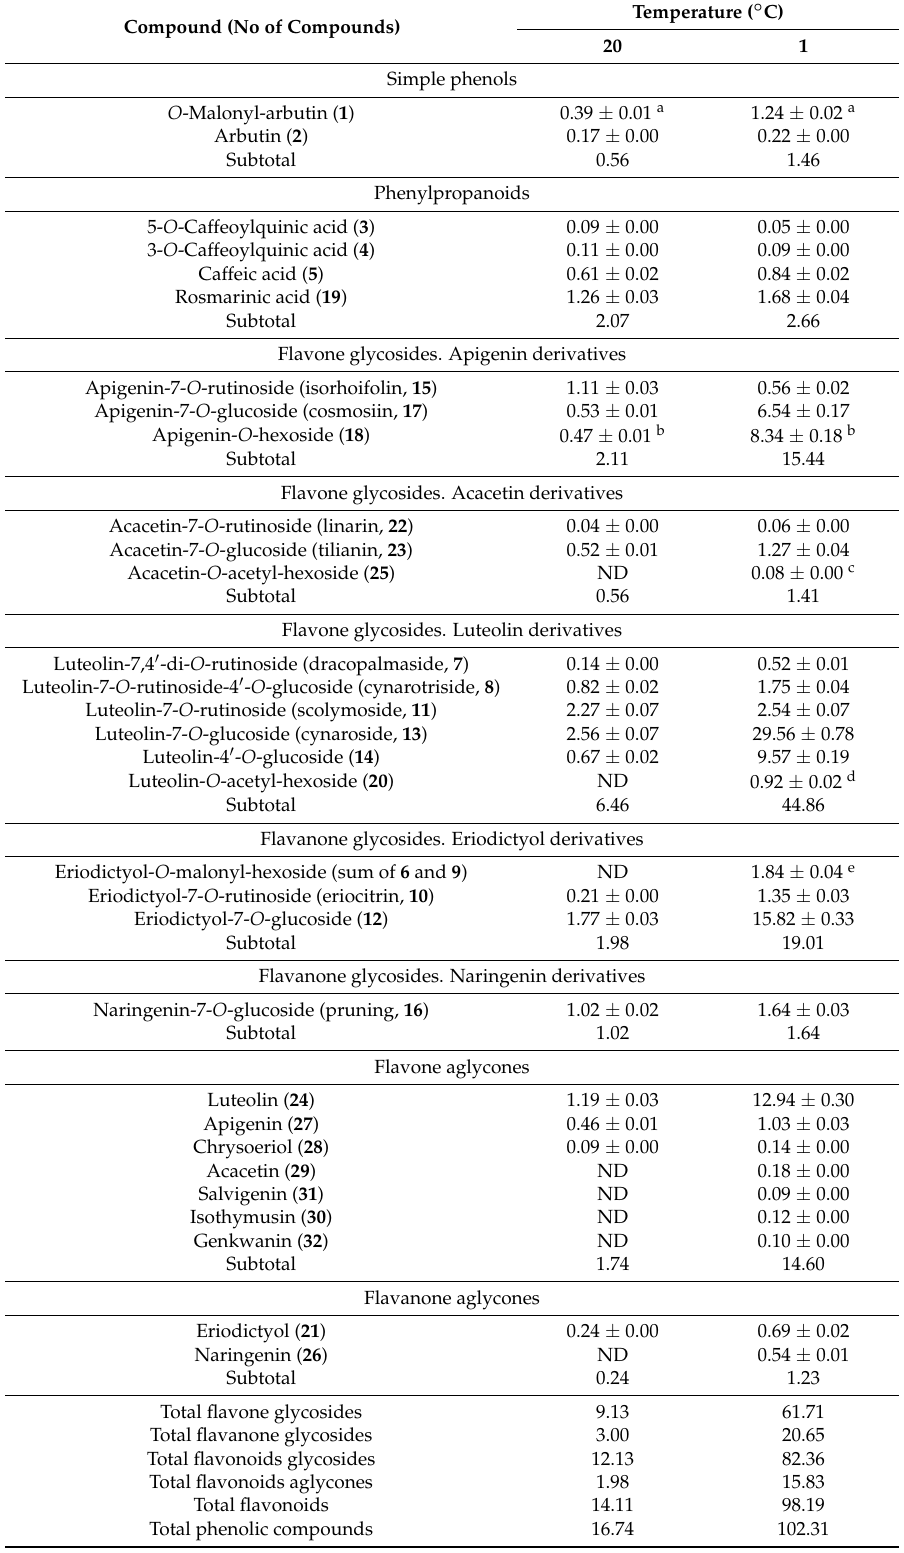
Table 5. Content of phenolic compounds (mg/g DW ± SD) in D. palmatum herb under different temperatures of cultivation.